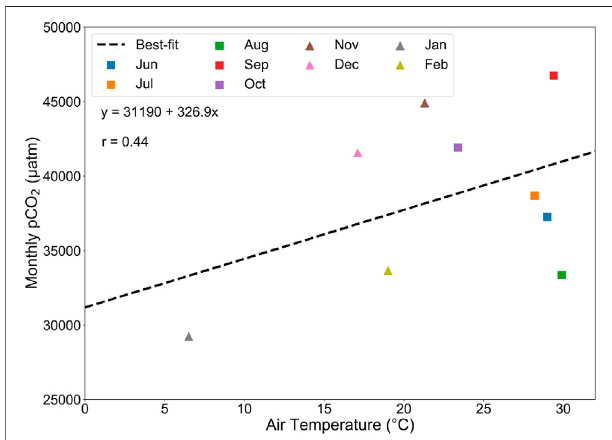
FIGURE 5 | The relationship between monthly pCO 2 at site A and ambient temperature. The dashed line represents the best- fi t line of the